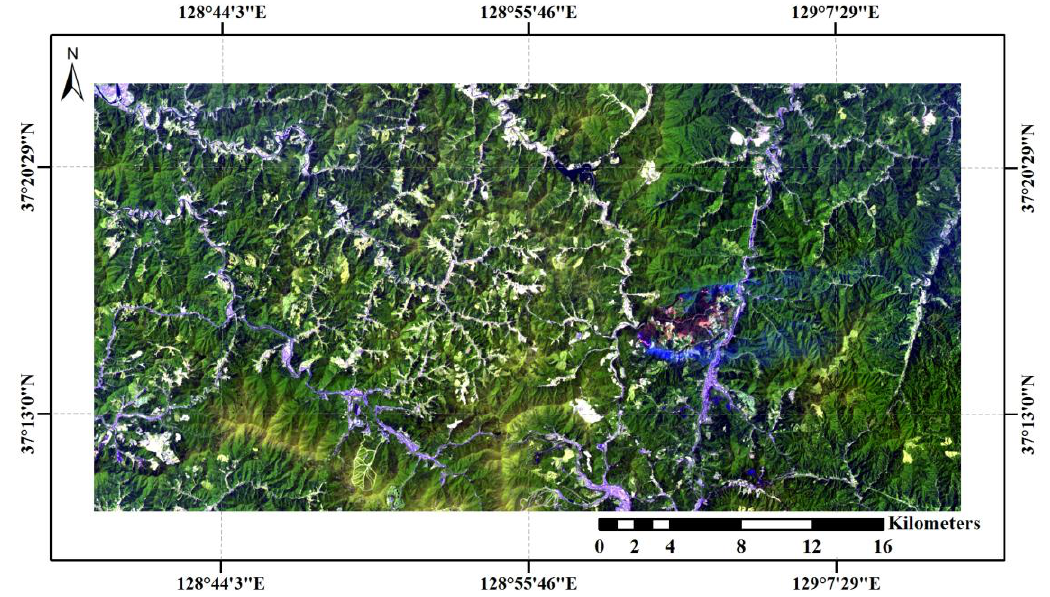
Figure 4. SWIR2-SWIR1-Blue color composites of the study area affected by wildfires.